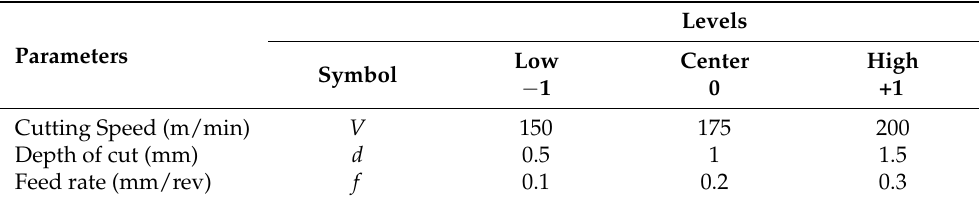
Table 5. The cutting parameters and levels affecting the turning of AISI 52100 bearing